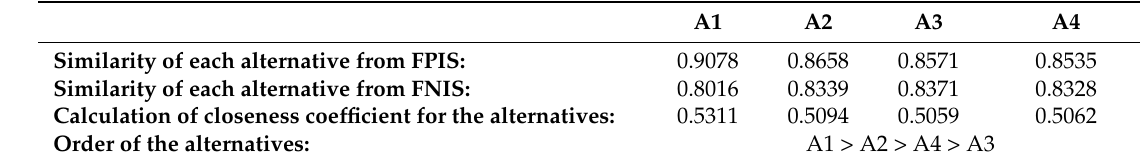
Table 12. Fuzzy-TOPSIS